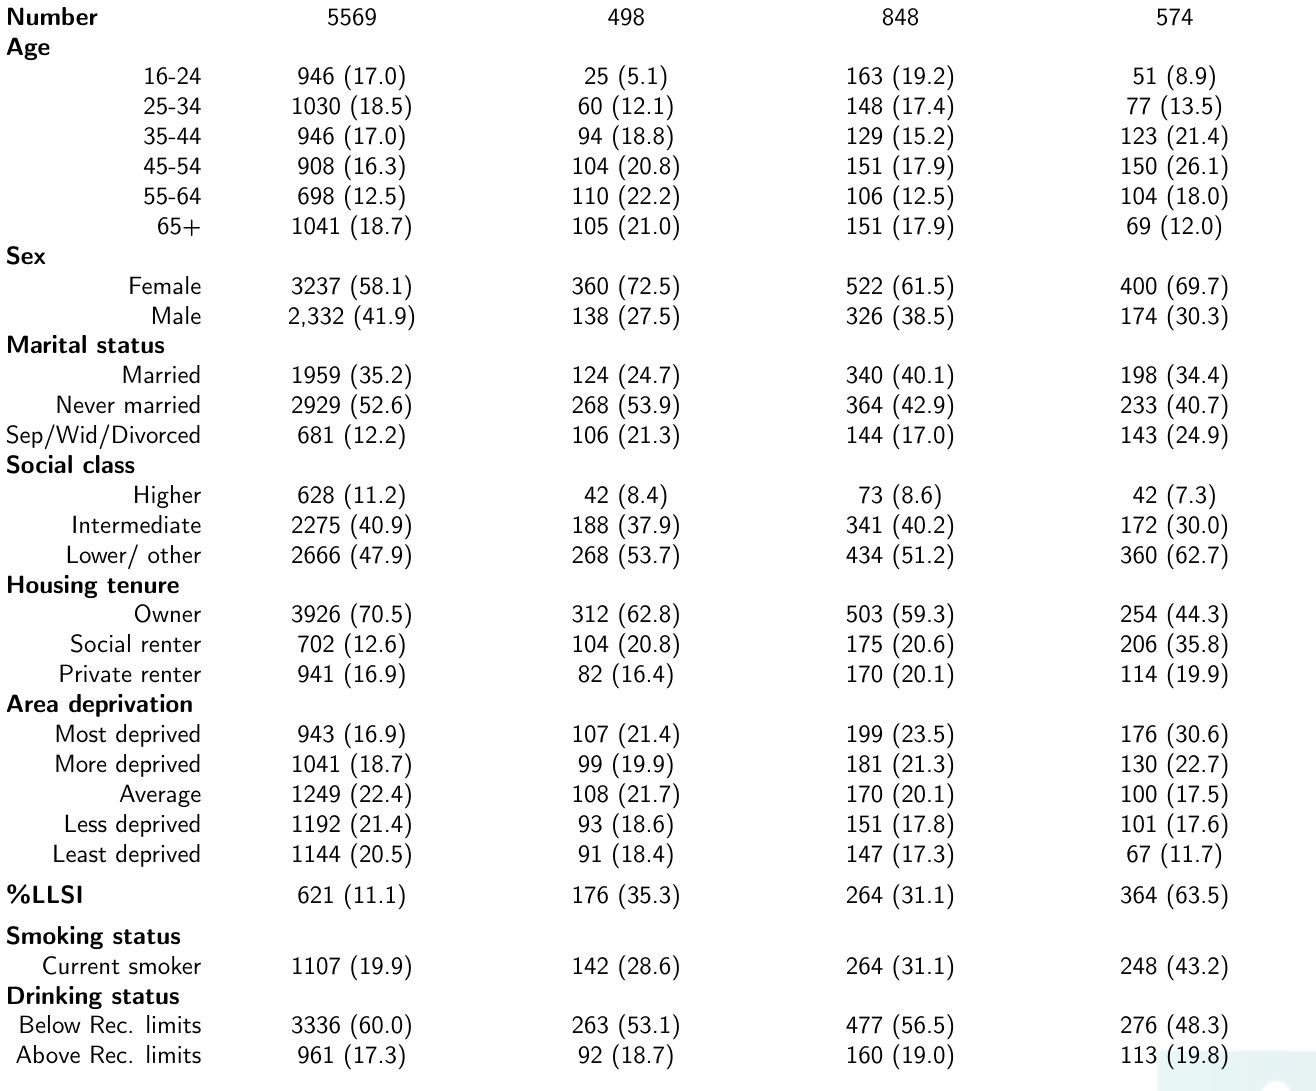
NB: Data represent population weighted numbers and percentages within each